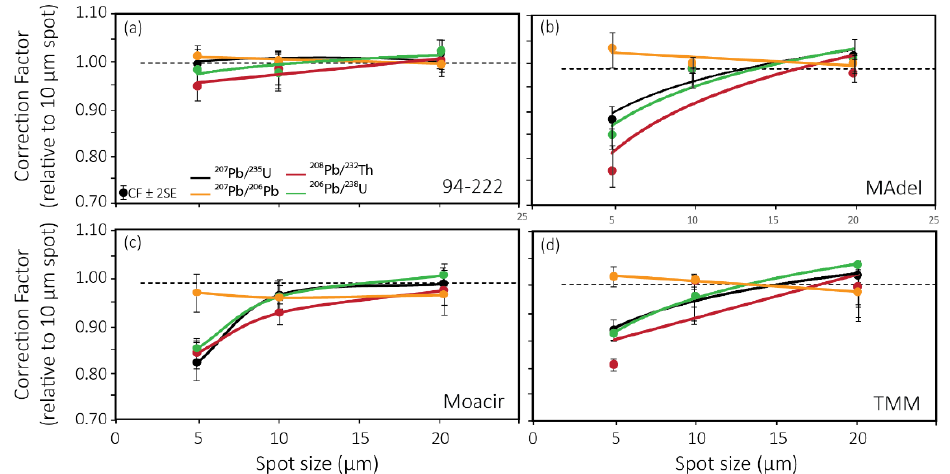
Figure 4. Correction factor versus spot size relative to 10 µm and 10 Hz of monazite sample USGS 44069 of analytical session 120605. The graph shows Th/Pb, U/Pb and Pb/Pb fractionation factors for ( a ) 94-222, ( b ) MAdel, ( c ) Moacir and ( d ) TMM. The dashed line represents the line at which the average measured ratio of the RM relative to the preferred ratio calculated for the given literature age should be equal. The bold colored line represents the calculated trendline for each decay